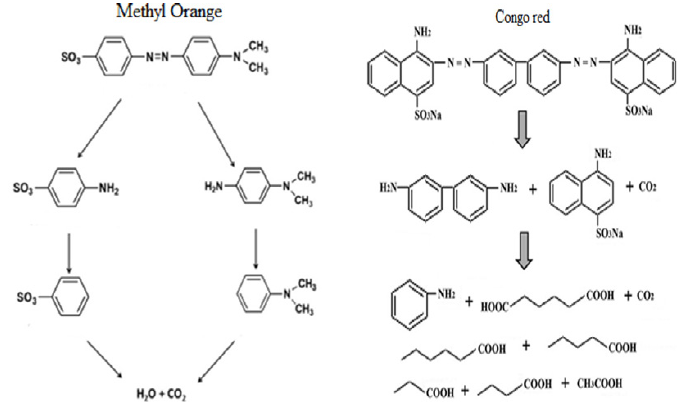
Scheme 1 Schematic diagram for accepted mechanism (methyl orange & congo red dyes visible light